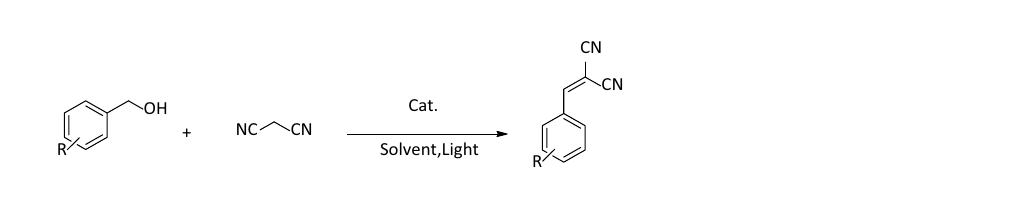
Figure 4. Model reaction for photocatalytic oxidative condensation